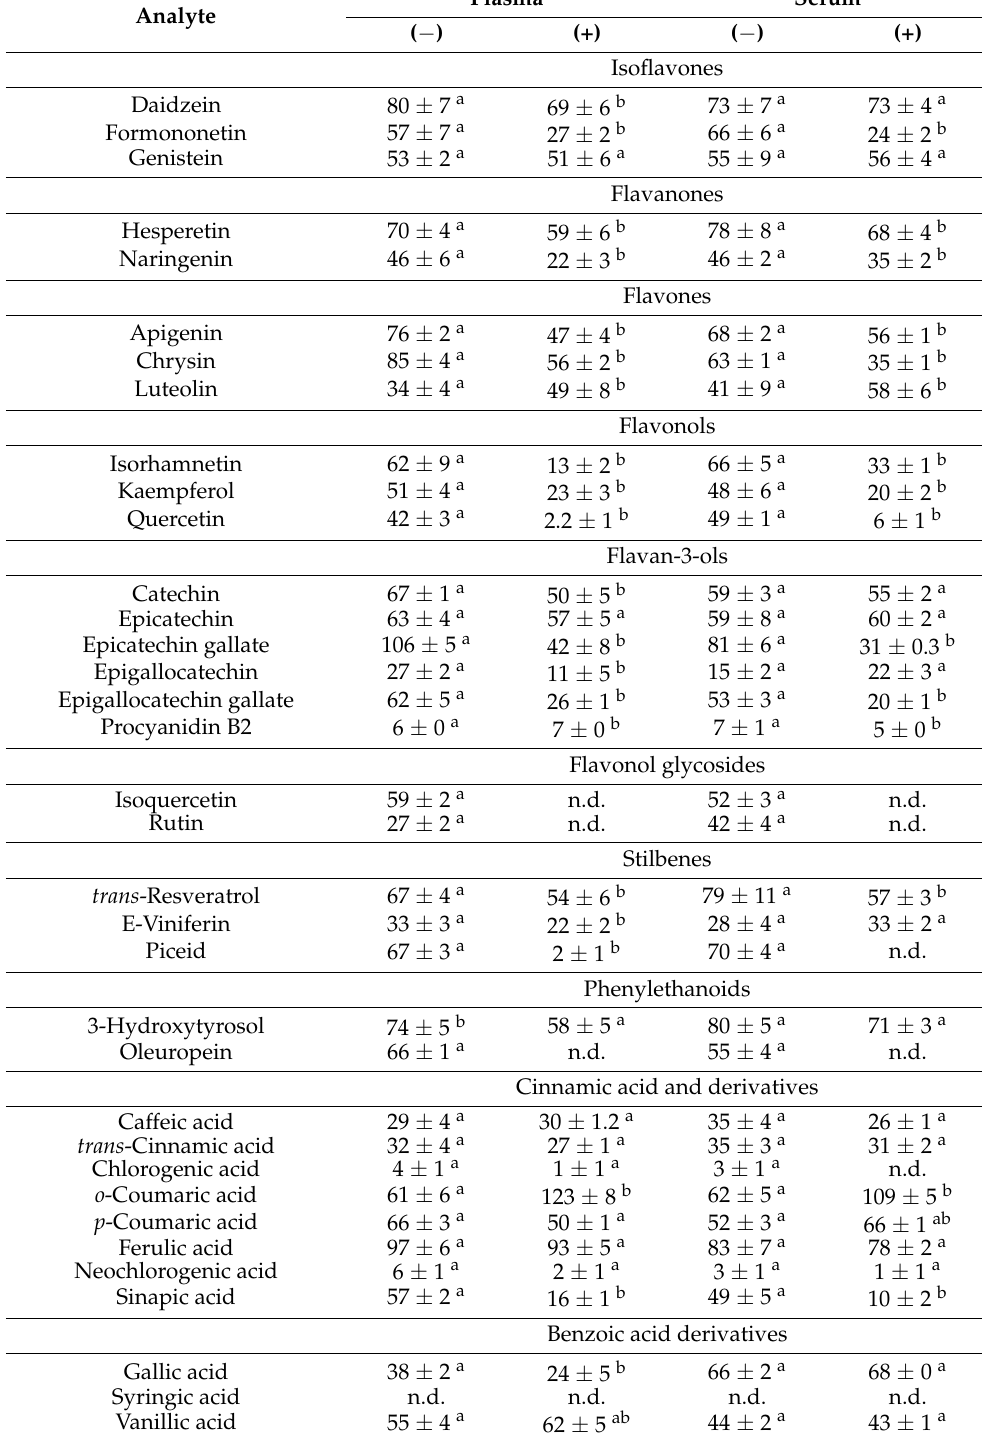
Data are presented as mean ± SD. Values in the same row not sharing lower case superscript letters indicate statistically significant differences among analyzed spiked plasma and serum samples in each case at a confidence level of 95%. Not detected